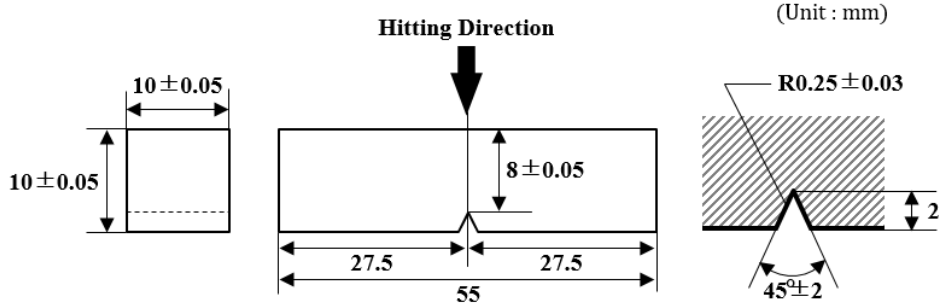
Figure 4. Schematic diagram of the Charpy impact test.